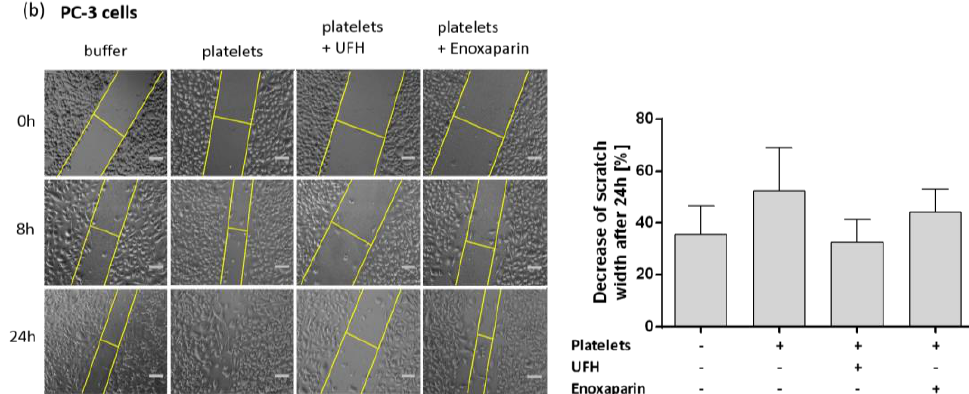
Figure 6. Representative images from wound healing assays of AsPC-1 cell and PC-3 cell cultures treated with buffer or platelets or platelets and heparins. Scale bar corresponds to 50 µ m. Quantification of scratch width decrease in percent is based on data of three independent experiments. ( a ) Wound healing assay after 72 h coincubation of AsPC-1 cells with buffer, platelets, platelets and UFH, or platelets and enoxaparin and 16 h serum-starvation. Images show the invasion of AsPC-1 cells into the cell-free region at the beginning (0 h), after 24 h and after 72 h. Histogram shows the decrease of the scratch size after 72 h (right part of the figure). ( b ) Wound healing assay after 72 h coincubation of PC-3 cells with buffer, platelets, platelets and UFH or platelets and enoxaparin and 16 h serum-starvation. Images show the invasion of PC-3 cells into the cell-free region at the beginning (0 h), after 8 h and after 24 h. Histogram shows the decrease of the scratch size after 24 h (right part of the figure).